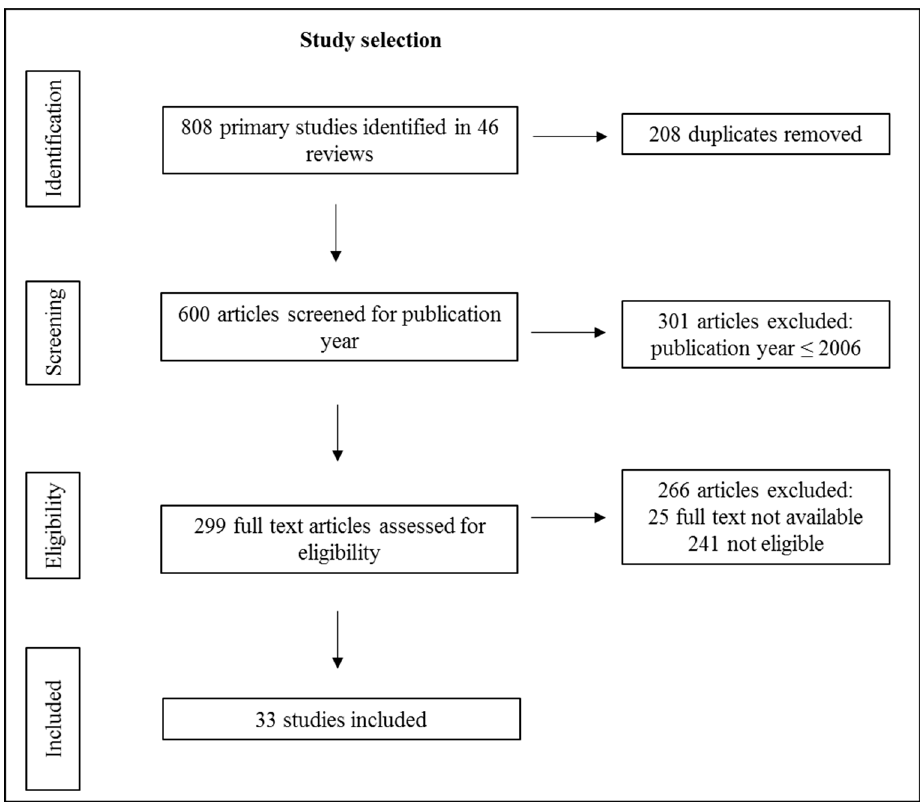
Figure 2. Flow chart of the study selection process (step 2).